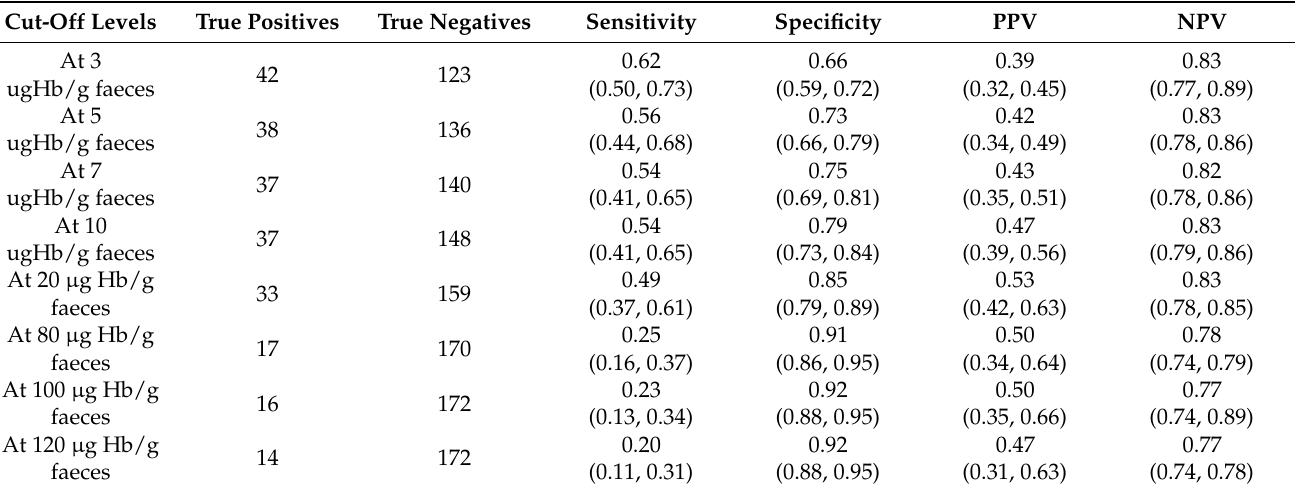
Table 2. Diagnostic test accuracy of faecal immunochemical test for the detection of a high-risk finding. Prevalence = 0.26.